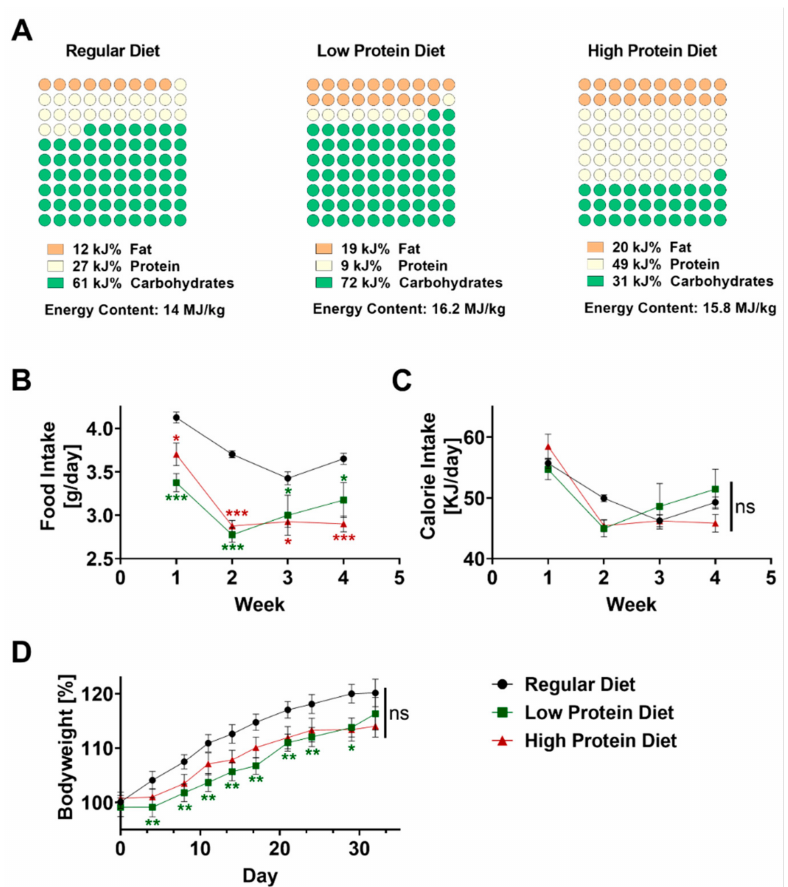
Figure 1. Effects of feeding a regular, low or high protein diet on food intake and bodyweight of C57BL/6J mice. ( A ) Composition of the dietary regimes. Percentage of fat, protein and carbohydrates as well as energy content. ( B ) Food intake of mice on a regular, low or high protein diet during the period of four weeks ( n = 4; 2-way ANOVA). ( C ) Calculated calorie intake during the feeding period of the same animals ( n = 4, 2-way ANOVA). ( D ) Change in bodyweight of the same animals during the period of four weeks on regular, low or high protein diet ( n = 30–32; 2-way ANOVA). Data are shown as mean ± SEM. Green asterisks show significant differences between control and low protein diet fed mice, red asterisks between control and high protein diet. *** p < 0.001; ** p < 0.01; * p <